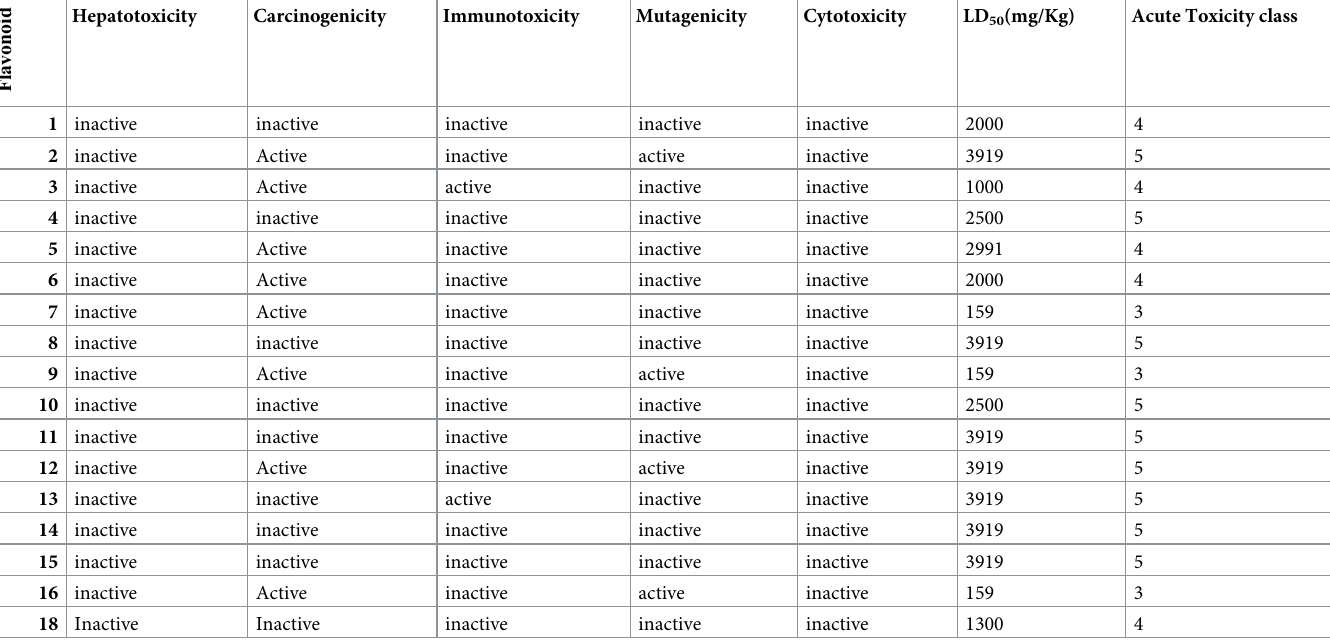
Table 5. Pro Tox II predicted organ toxicity, toxicological end points and acute